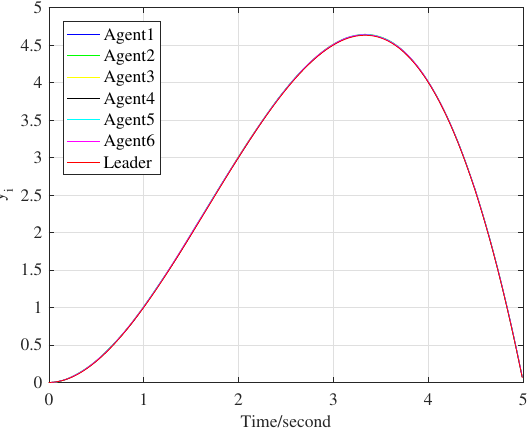
Figure 4. Tracking process at 70th iteration.